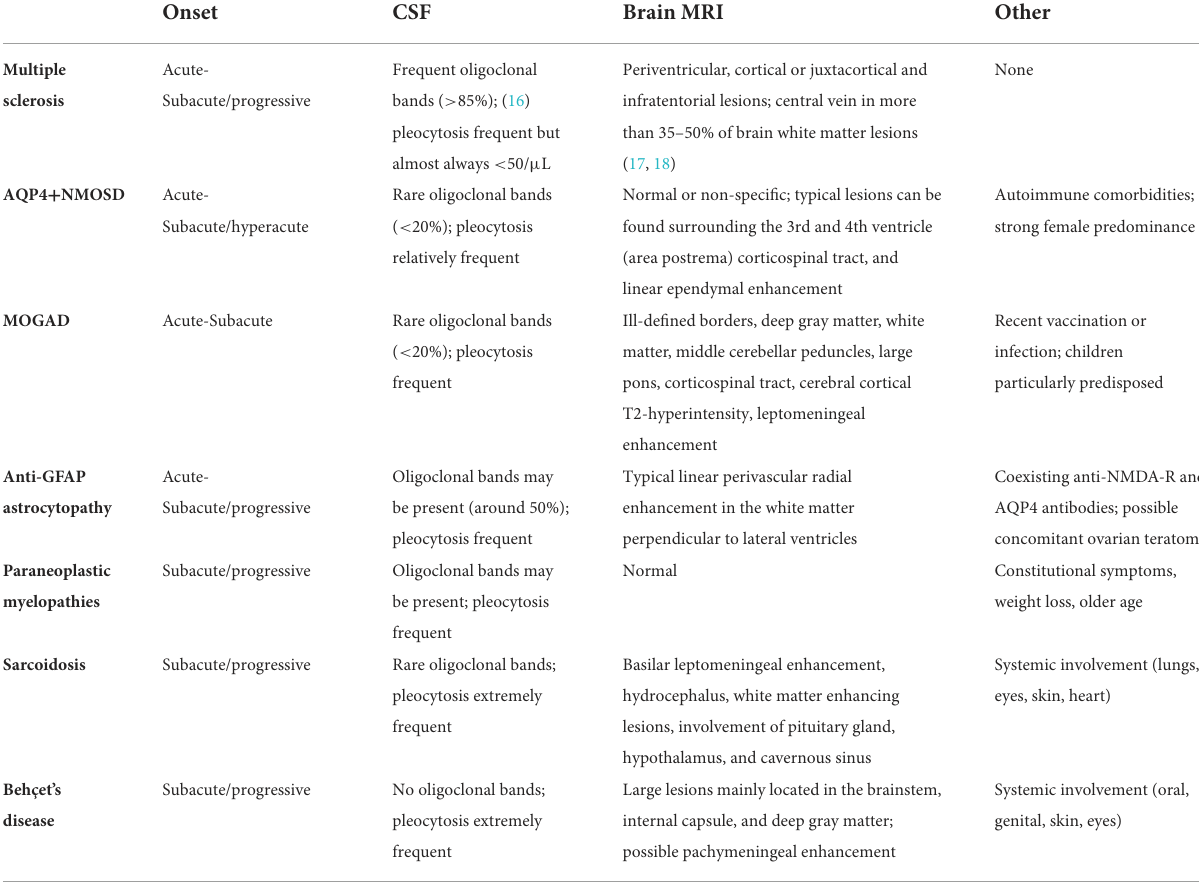
TABLE 1 Clinical and paraclinical features of the main causes of inflammatory